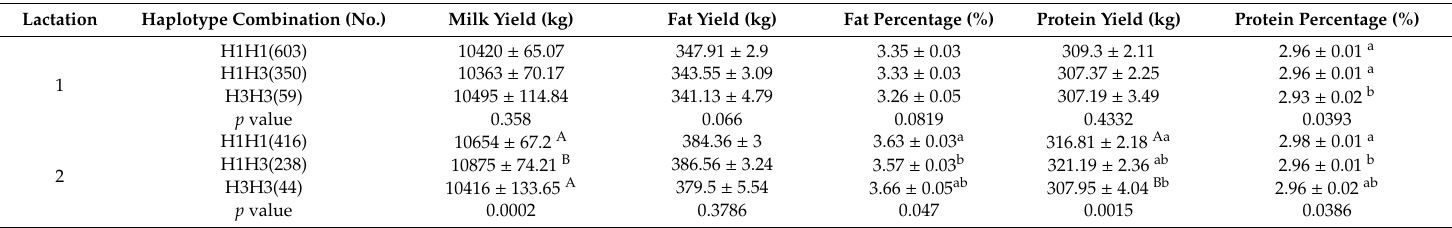
Table 3. Associations of haplotype blocks with milk production traits in two lactations in Chinese Holstein (LSM ± SE).